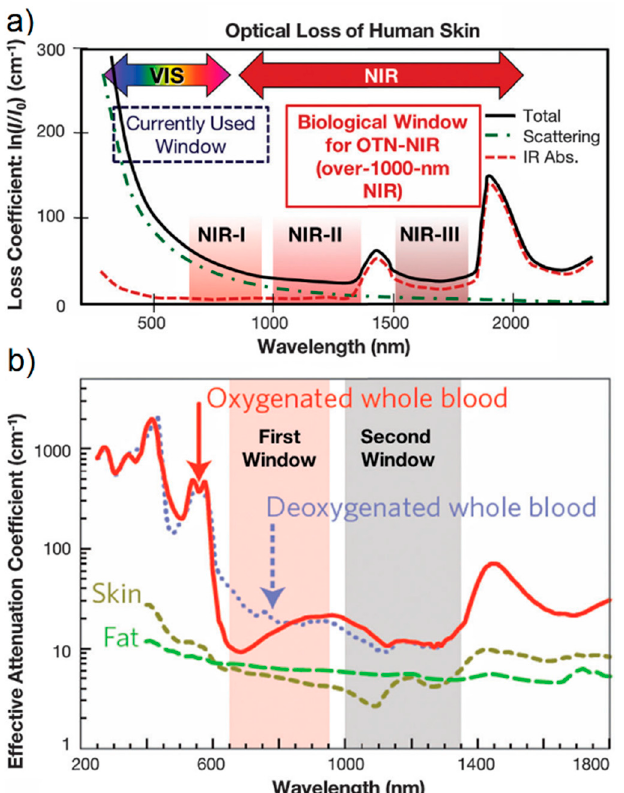
Figure 16. ( a ). Absorption (dash red line), scattering (dash-dot green line), and extinction (solid black line) of human skin as a function of the wavelength. The three transparency windows are indicated as NIR-I, NIR-II, NIR-III. Reproduced with permission from Hemmer et al. [276]. Copyright (2013), the Royal Society of Chemistry. ( b ) Extinction coefficient of oxygenated blood (solid red line), deoxygenated blood (dotted blue line), skin (ochre dash line), and fatty tissues (green dash line). Reproduced with permission from Smith et al. [277]. Copyright (2009), Macmillan Publishers Limited.